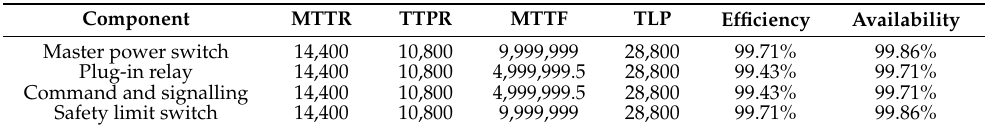
Table 6. Electrical components times in seconds. Efficiency and availability calculated in % with PPM strategy.